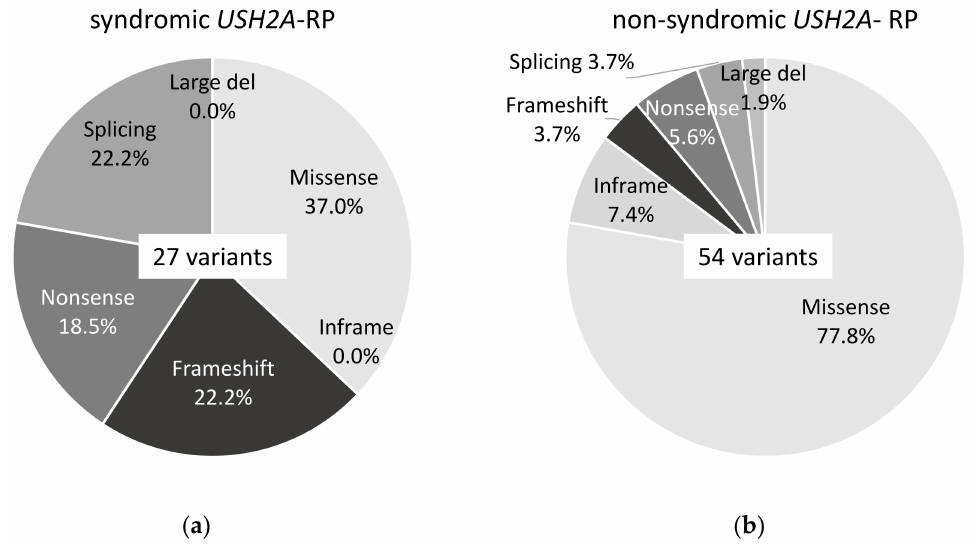
Figure 2. Frequency of each type of USH2A variant in this study. ( a ) Frequency of 6 types of 27 USH2A variants in syndromic USH2A -RP patients ( n = 11). ( b ) Frequency of 6 types of 54 USH2A variants in non-syndromic USH2A -RP patients ( n = 25).